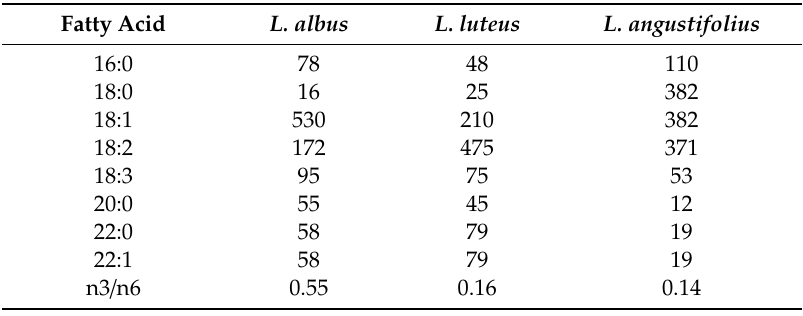
Table 2. Fatty acid composition (g / kg DM) in di ff erent lupine species. Fatty Acid L. albus L.